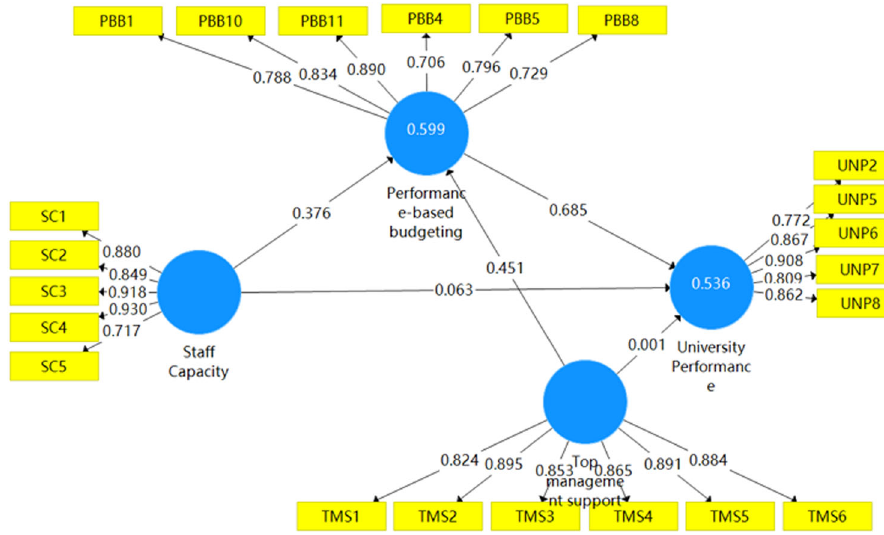
Fig. 2 Structural model evaluation. The fi nal model with factor loadings, path coef fi cients, and endogenous construct R 2 .